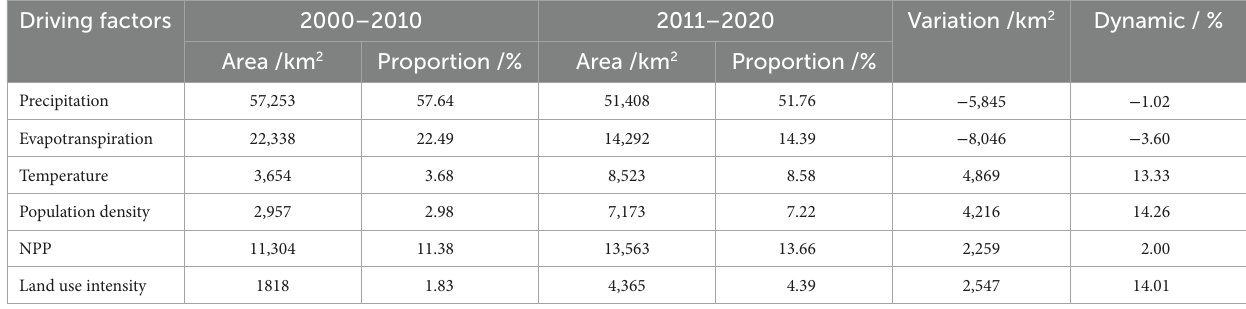
TABLE 3 Summary of control area of the main impact factors of WYs.